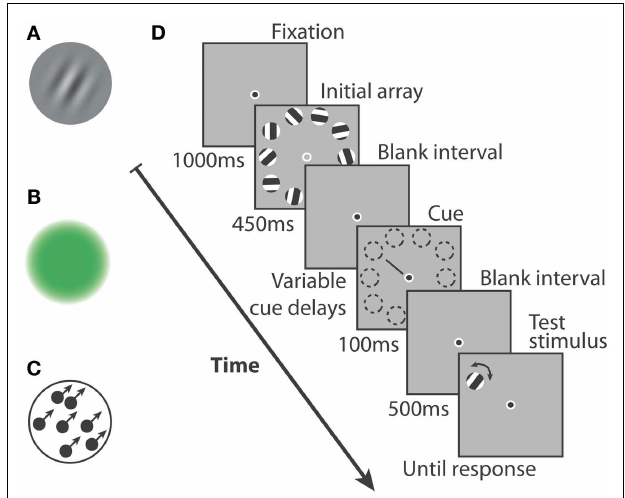
FIGURE 1 |Three types of stimuli were used in this study: (A) Gabor patches that could vary in orientation, (B) uniform hue patches that varied smoothly from red to green, (C) dot motion kinetograms, moving with 100% coherence, that could vary in direction of motion. (D) A single trial had the following structure: after maintaining fixation, participants were shown an array of 10 stimuli for 250ms (color or motion) or for 450ms (orientation). From the offset of the initial array and with variable delay, a cue could appear. It would point at one of the 10 stimulus locations for 100ms. After an interval of 500ms, a test stimulus would appear at the cued location and the participant had to signal the direction of change in feature space (two alternative forced